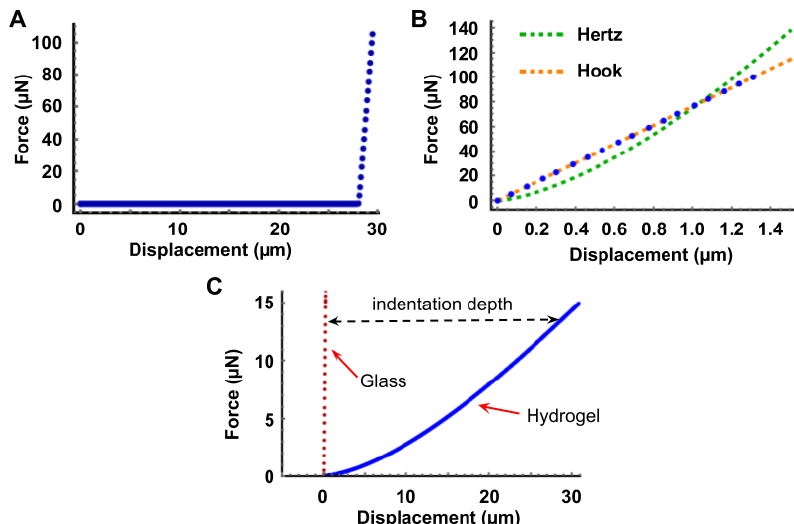
Polymers 2021 , 13 , x FOR PEER REVIEW 21 of 29 Figure A1. Example of the determination of the contact point, start of relaxation (maximum force) and indentation depth